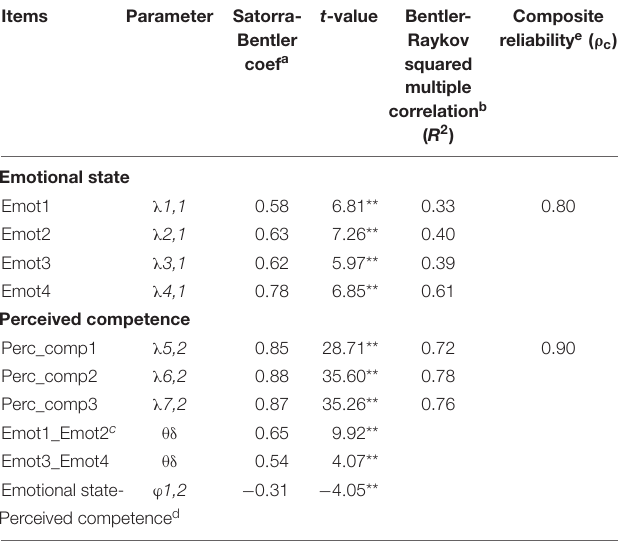
TABLE 2 | Measurement models for students’ emotional state and perceived competence.